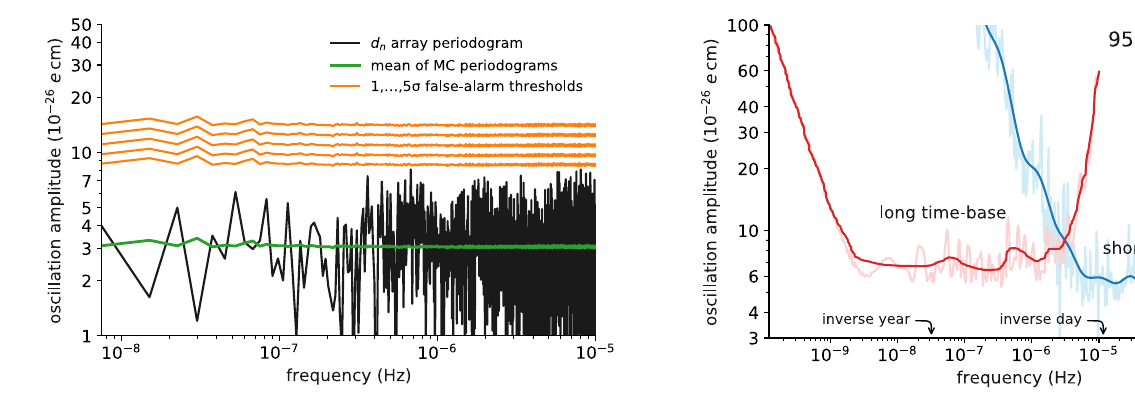
FIG. 1. The periodogram of the array of neutron EDM ( d estimates from the ILL measurement (black line). We are sensitive to oscillations in the quantity d d is the EDM of the 199 Hg atom. The mean of Monte Carlo- Hg generated periodograms, assuming no signal is present, is depicted in green. MC simulation is used to deliver false-alarm thresholds (global p values), marked in orange for 1 ; 2 ; … ; 5 σ levels (from bottom to top). The highest peak has the global p value 0.53, consistent with a nondetection.